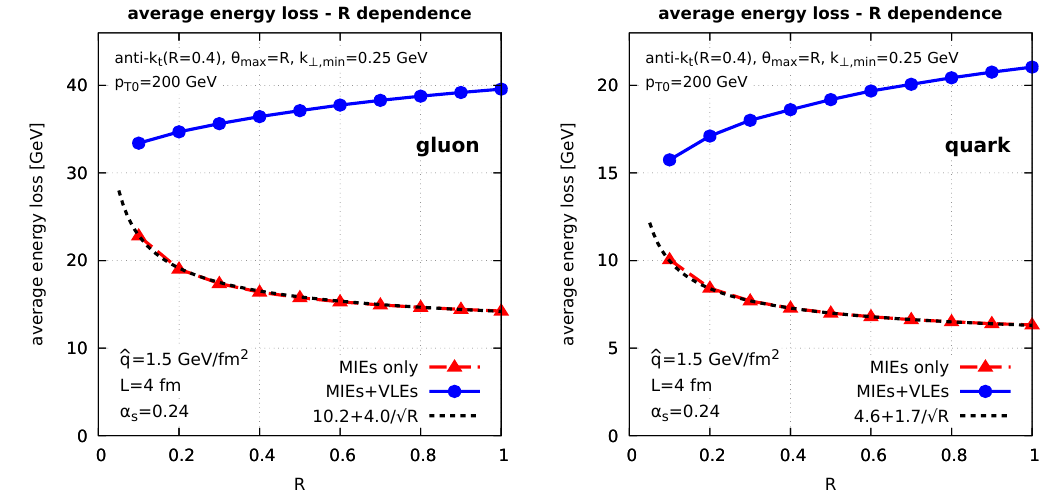
Figure 5 . The MC results for the average energy loss by the jet are displayed as a function of the jet angular opening R , for the same choices as in (cid:12)gure 4. We also show in dashed line a (cid:12)t (inspired by the theoretical estimate in eq. (2.14)) for the jet built with MIEs